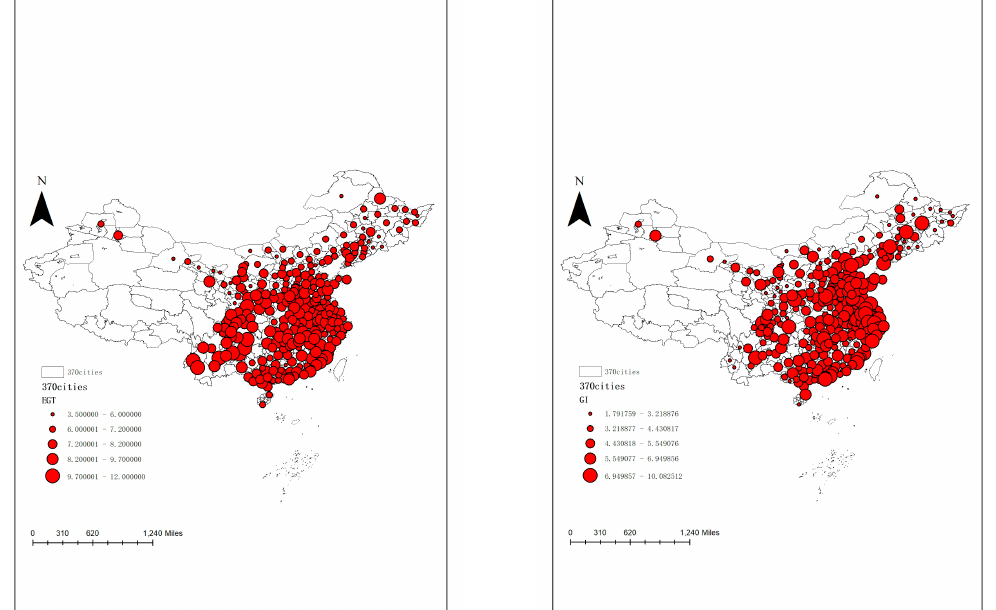
Figure 3. Spatial distribution of EGT and GI in 2018.